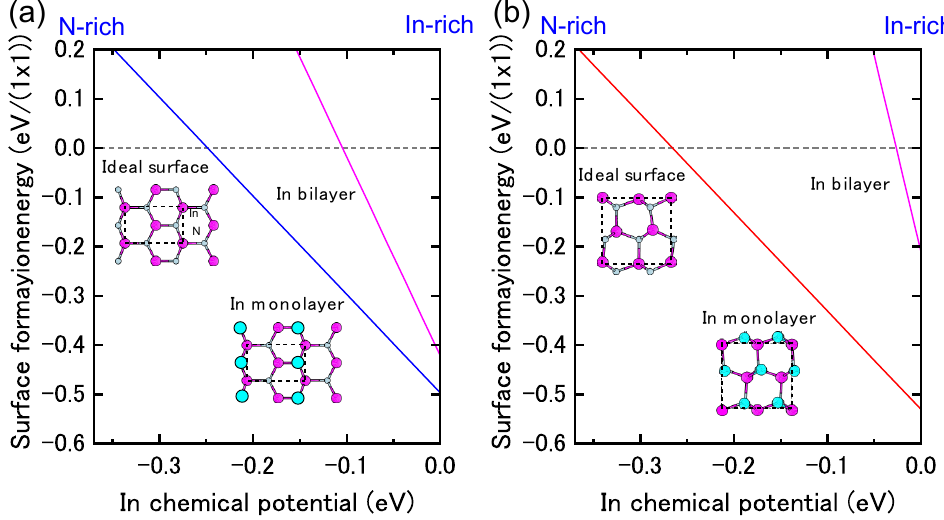
Figure 19. Calculated surface formation energies for nonpolar InN surfaces with _ _ 00) and ( b ) (11 2 0) orientations as a function of the In chemical ( a ) (1 1